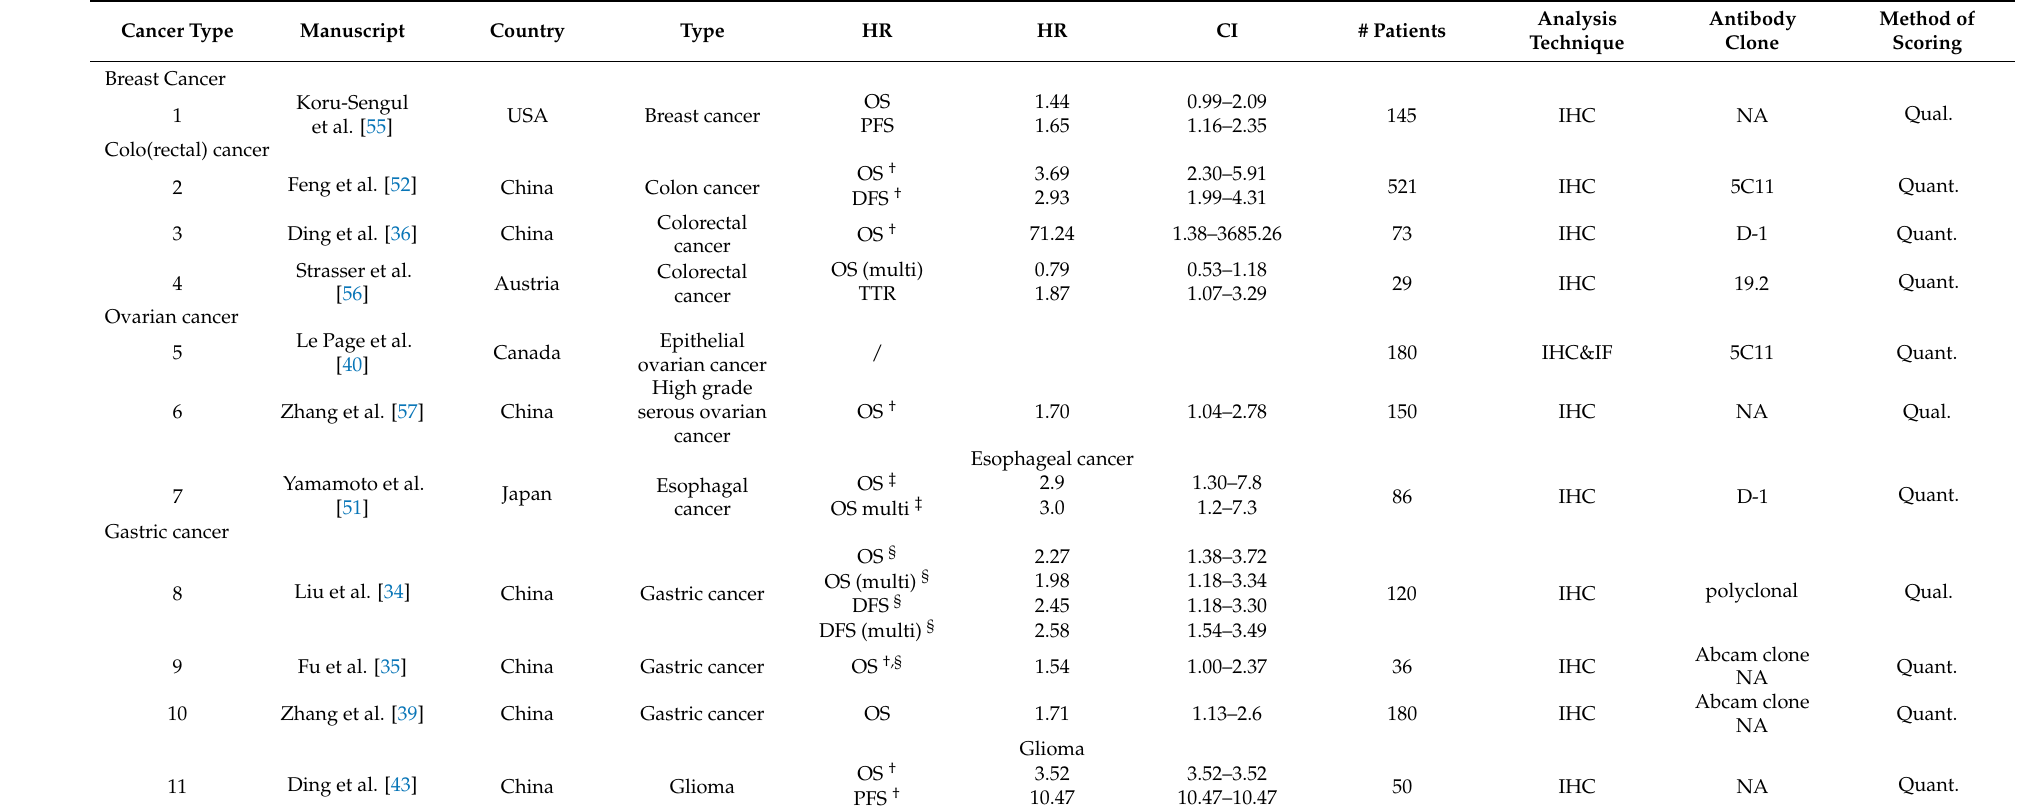
Table A4. Characteristics of included